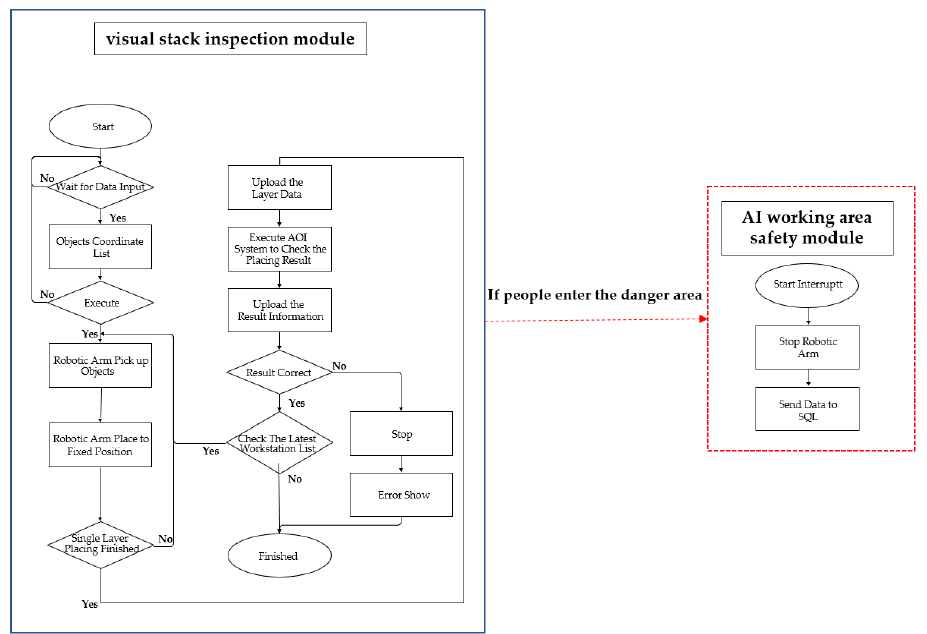
Figure 22. Vision system process flowchart.